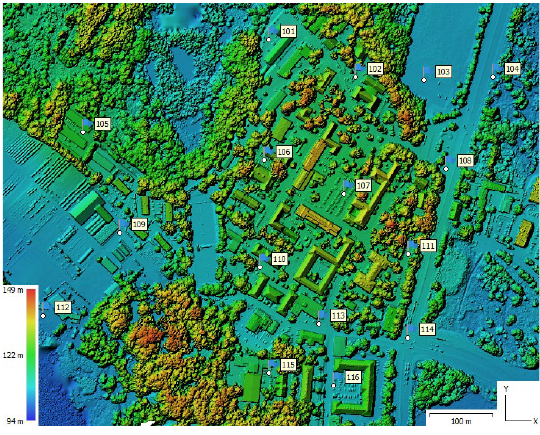
Figure 6. Visualization of DEM generated in Metashape The CloudCompare (Girardeau-Montaut, 2019) application was used to analyze the vertical deviations (VD) between generated DEM and the adjusted LiDAR point cloud. The last squares planar fitting of 3D points (James et al., 2017b) was applied to achieve a better approximation of true distances. The results are presented in Figure 7.